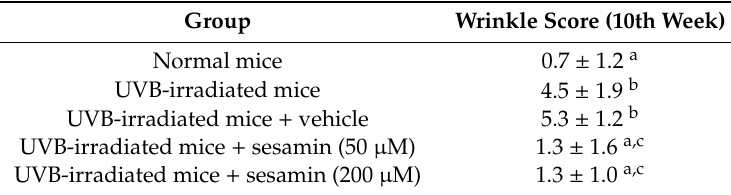
Figure 15. Photographs show skin wrinkles induced by the chronic UVB irradiation and the effect of topically applied sesamin. Table 1. Effect of sesamin on skin wrinkles induced by the UVB irradiation in hairless mice.